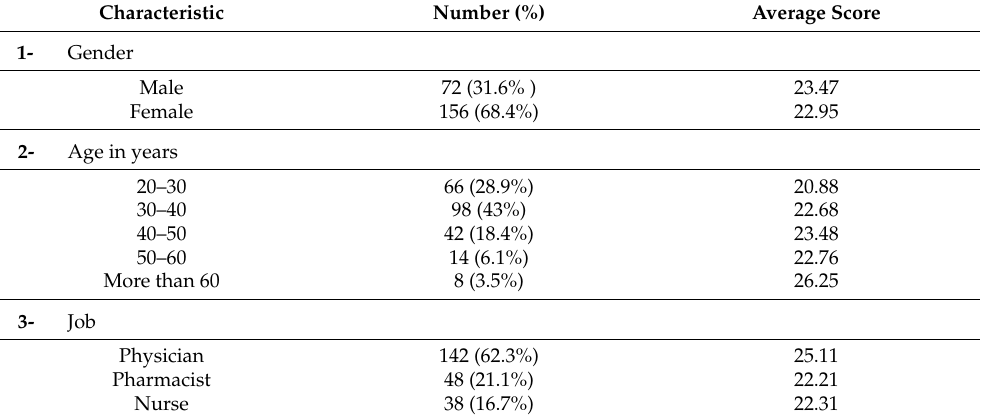
Table 1. Participants’ demographic data.